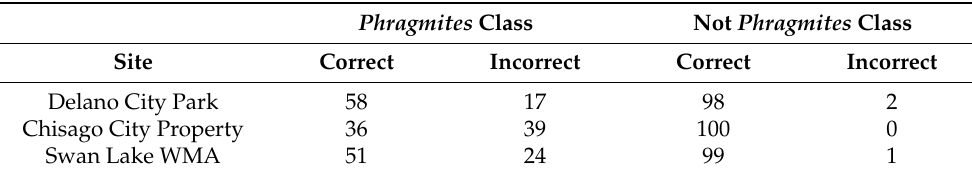
Table 14. Validation assessment points for each of the three validation sites for the random forest classification without the post-ML OBIA rule set.